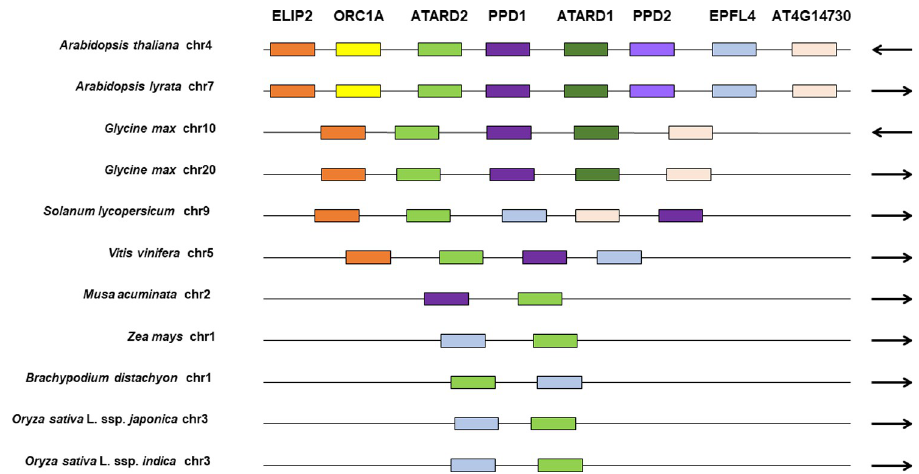
Fig 3. Schematic diagram illustrating syntenic comparison of PPD and flanking genes in dicotyledons and monocotyledons. Arrows indicate chromosome strand; where appropriate, the gene order has been reversed for easy graphical view. PPD1 and PPD2 are both shaded purple to signify they are very similar and in cases where only one orthologous protein was found in another organism it may represent either of the two genes. Similarly for ATARD1 and ATARD2. Only the closest syntenic clusters relative to the PPD gene are shown for G . max ; S . lycopersicum , V . vinifera and M . acuminata